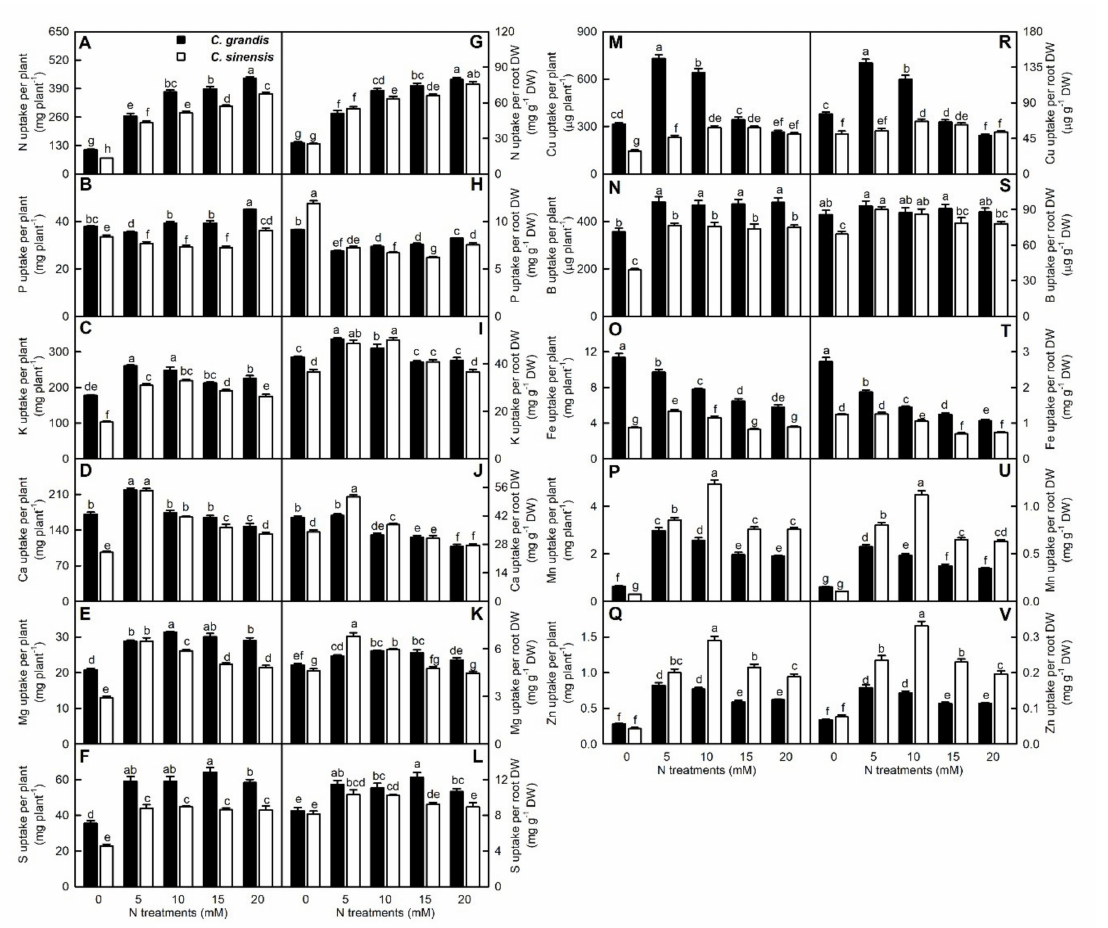
Figure 4. Effects of N supply on mean ( ± SE, n = 4) element uptake per plant ( A – F , M – Q ) and per root DW ( G – L , R – V